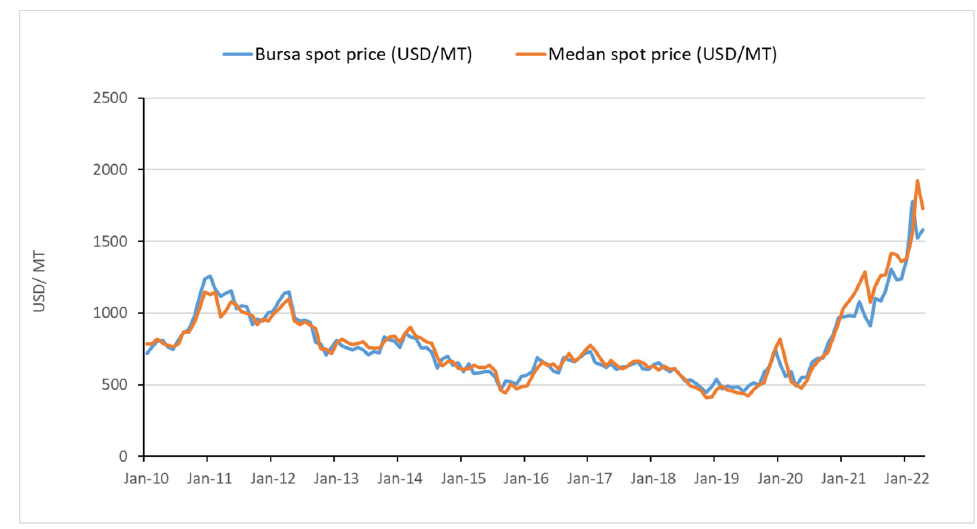
Figure 2. Malaysia and Indonesia monthly average spot crude palm oil price comparison.